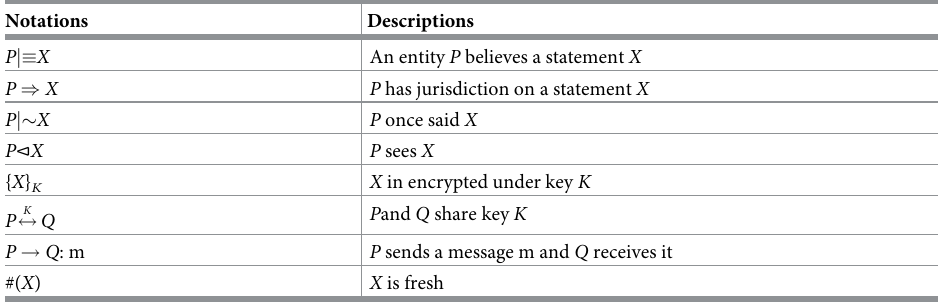
Table 2. BAN logic notations and respective